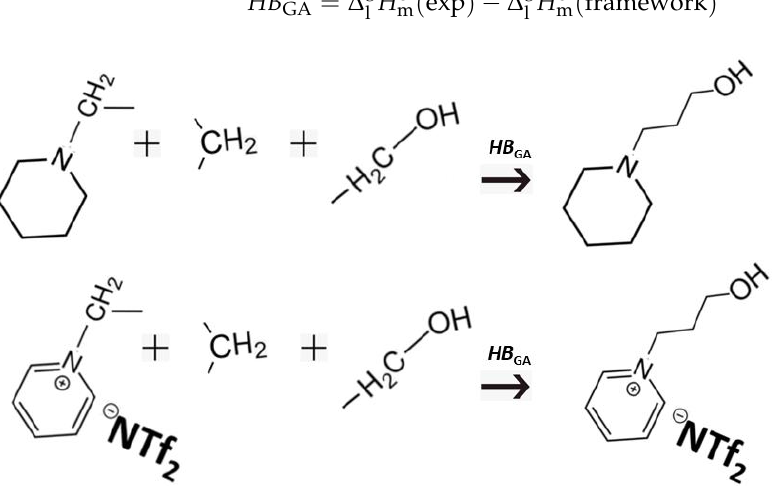
Figure 4. Group additivity: the develo pment of the “non -hydrogen- bonded” frameworks for calcu- lating the intra-molecular hydrogen-bonding strength, HB GA , in hydroxy-alkyl-piperidines and hy- droxy-alkyl-pyridinium [NTf 2 ] ionic liquids.